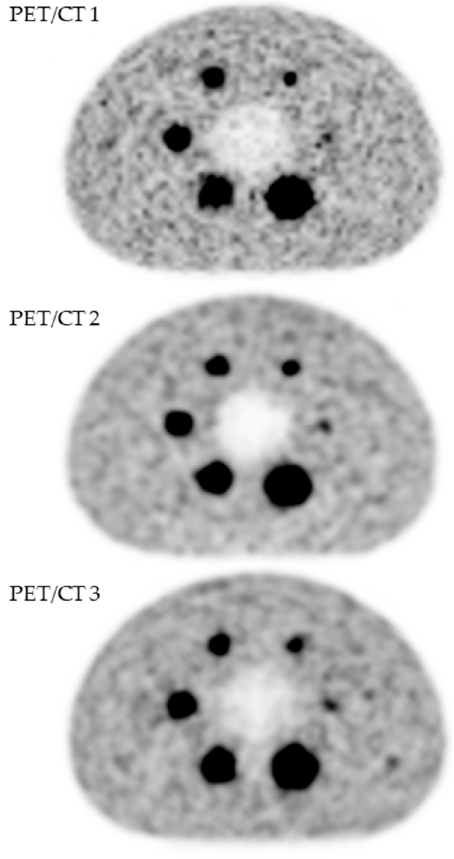
Figure 1. Quality assessment of [ 18 F]FDG PET images obtained with three PET/CT systems (GE Healthcare USA, Inc., Chicago, IL, USA): Discovery ST (PET/CT 1), Discovery 690 (PET/CT 2) and Discovery IQ5 (PET/CT 3).